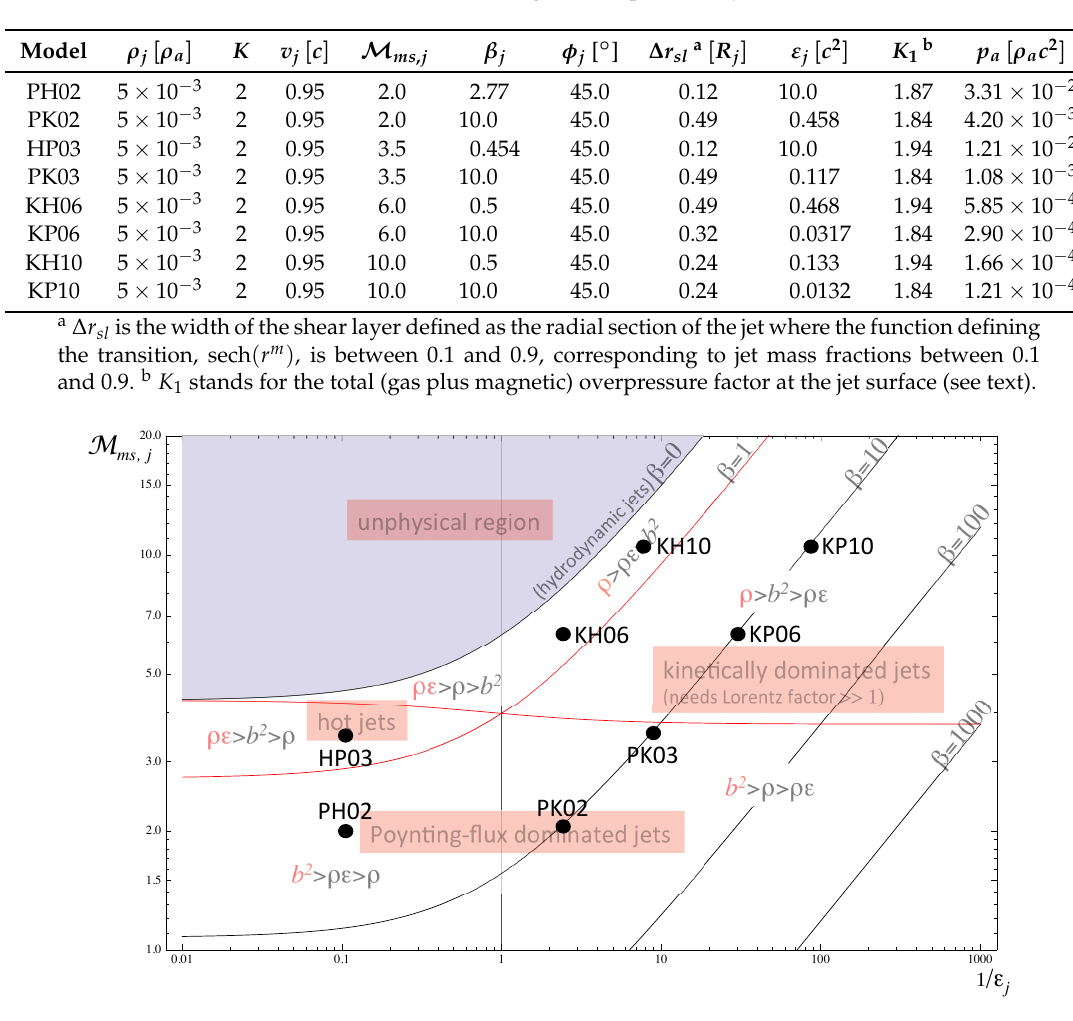
2 = ρ = ρ j ε j , b j . Pure j j